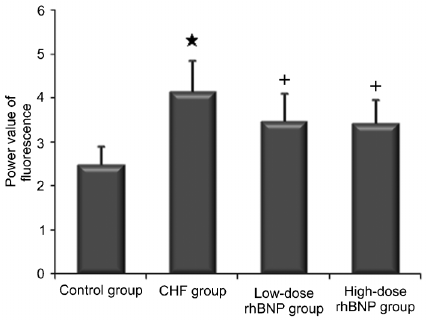
Figure 5. Power values of CYP11B2 fluorescence measurement in each group of rats. Data are reported as means±SD. CHF: chronic heart failure; rhBNP: recombinant human brain natriuretic peptide *P , 0.01 vs control group; + P , 0.05 vs CHF group ( t